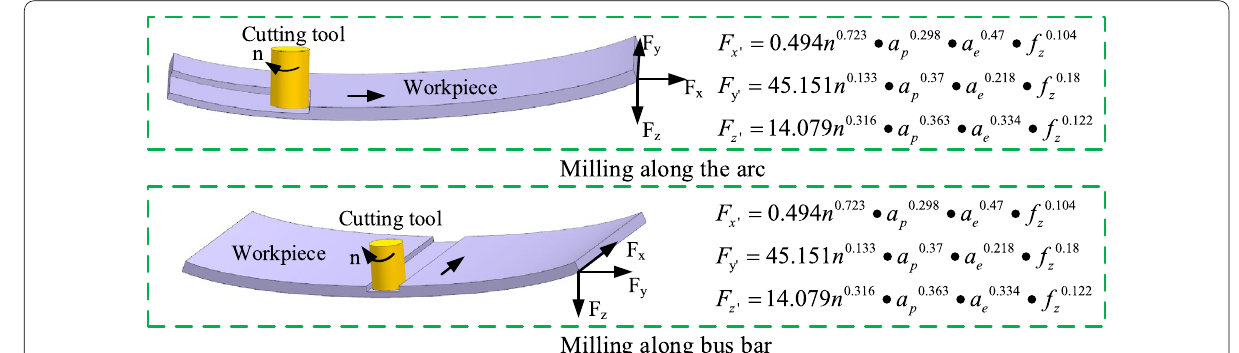
Figure 5 Milling along arc line and generatrix of arc plate